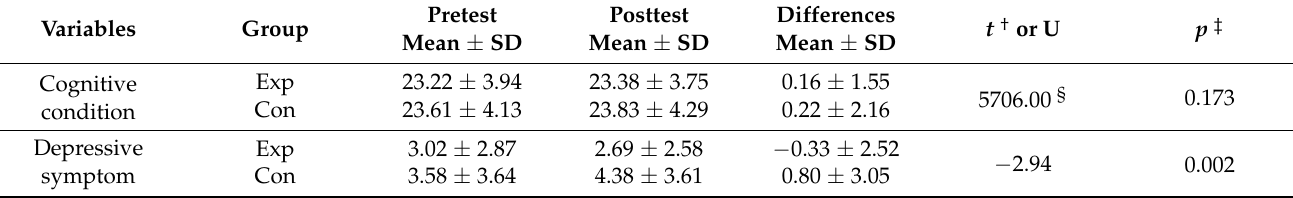
Table 3. Comparing the effects of the physical exercise program on cognitive function and depression. Variables Group